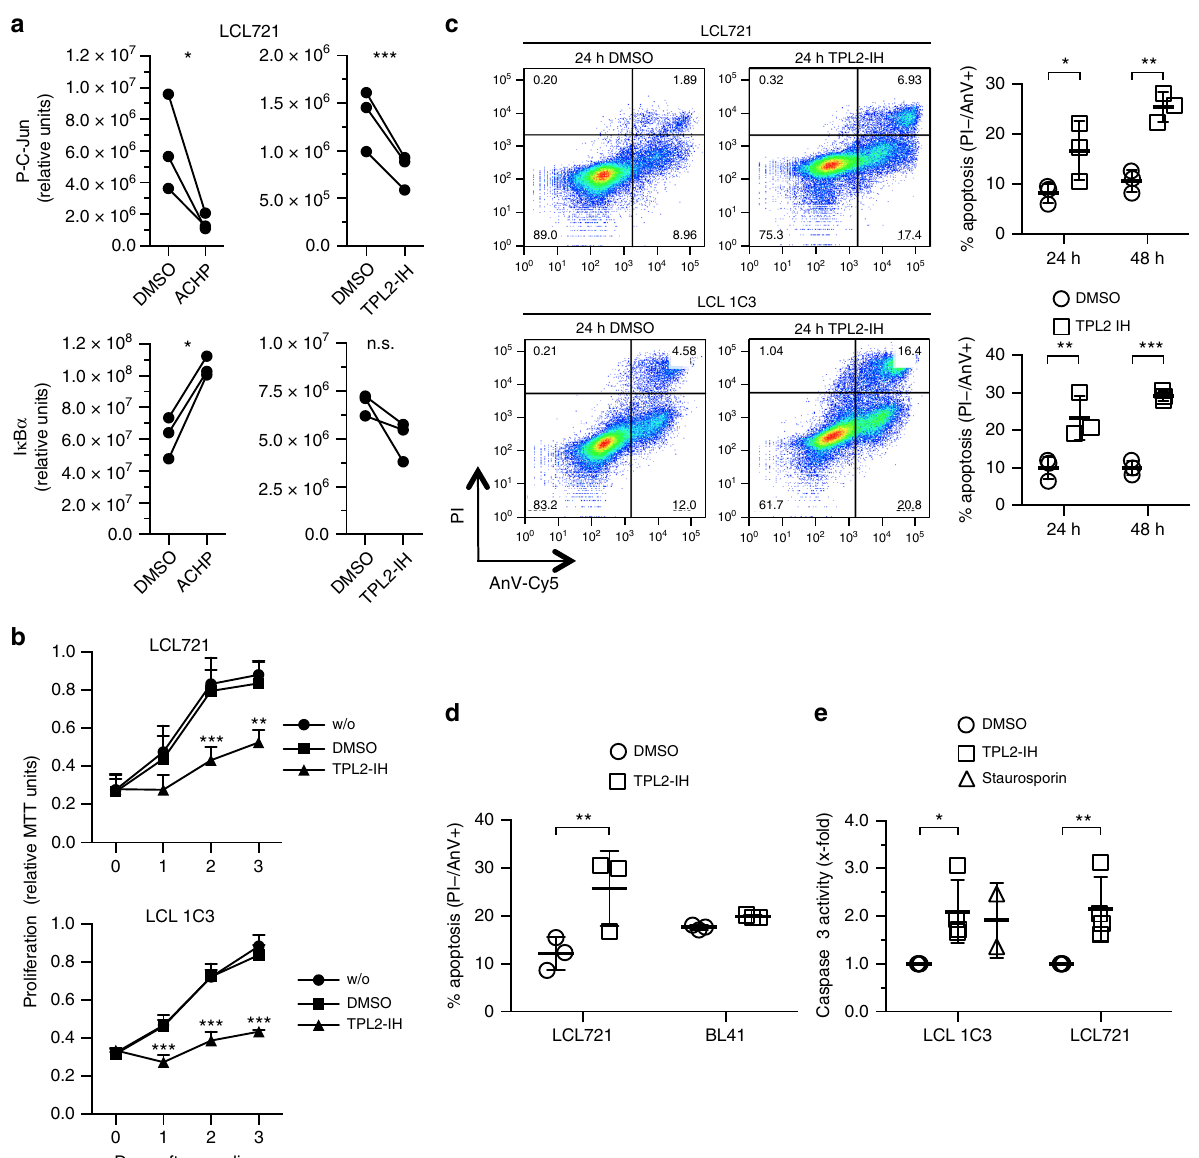
Fig. 7 TPL2 activity is required for proliferation and survival of EBV-transformed human B cells. a IKK2 and TPL2 inhibition causes downregulation of the JNK pathway in lymphoblastoid cell lines (LCLs). Quantitative immunoblot analysis of LCL721 cells kept in the presence of DMSO, 10 µ M of ACHP (left panels) or TPL2-IH (right panels) for 3 h. The indicated antibodies were used. Paired signals standardized to total protein levels of three biological replicates are shown. Chemiluminescence values ( y -axes) are relative and do not allow for direct comparison between graphs. b TPL2 inhibition retards proliferation of LCLs. LCL721 and LCL 1C3 cells were incubated in the absence or presence of DMSO or 10 µ M TC-S7006 (TPL2-IH). Proliferation was determined as MTT conversion. Data are mean values± SD of three biological replicates. c TPL2 inhibition causes apoptosis in LCLs. Cells were kept in the presence of DMSO or 10 µ M TPL2-IH for 24 or 48 h, stained with propidium iodide (PI) and Annexin V-Cy5, and analysed by fl ow cytometry. FACS plots of one representative experiment after 24h are shown. Percentages of AnV + /PI − cells indicating apoptotic cells are given in graphs as mean values ± SD of three biological replicates. d Cell death after TPL2 inhibition is speci fi c for EBV-transformed B-cells. LCL721 and EBV-negative BL41 B-cells were grown in the presence or absence of TPL2-IH for 24 h and apoptosis rates were determined. Data are mean values± SD of three biological replicates. e The activity of caspase 3 is increased in LCLs after TPL2 inhibition. Caspase 3 activity was measured after incubation of cells with DMSO or 10 µ M TPL2-IH for 24 h. Staurosporin treatment for 4 h served as positive control and reference. Data represent the x-fold change ± SD of three biological replicates. a Statistical analysis was performed with the ratio paired T -test (two-tailed). b – e Statistical analysis was performed with two-way ANOVA at alpha 0.05. a – e p